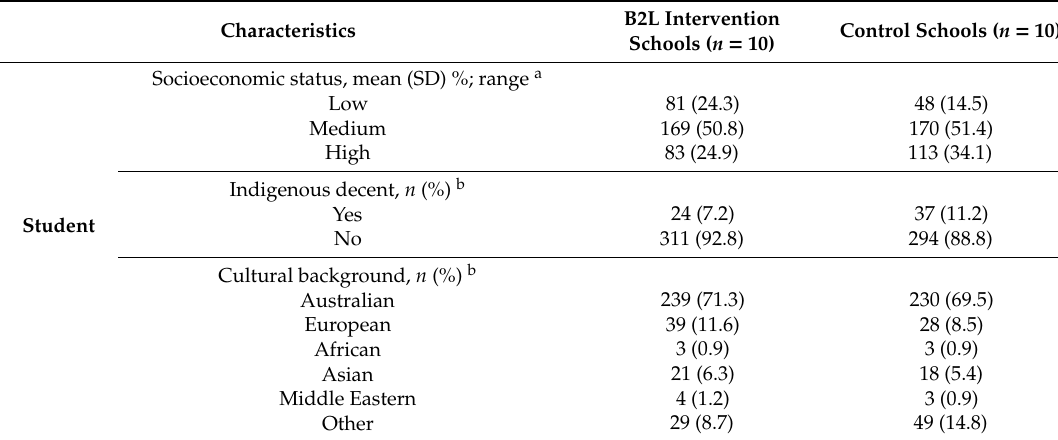
Table 2. Characteristics of B2L Students and